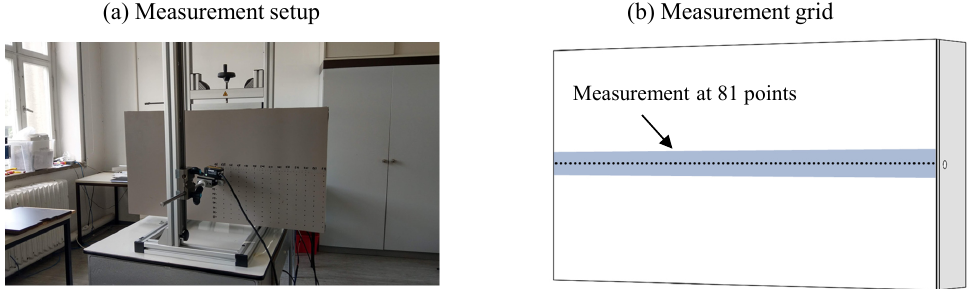
Figure 13. ( a ) Measurement setup with a Keyence HK-052 laser at the Technical University of Dresden. ( b ) Overview of the measurement grid: 81points on the central line are